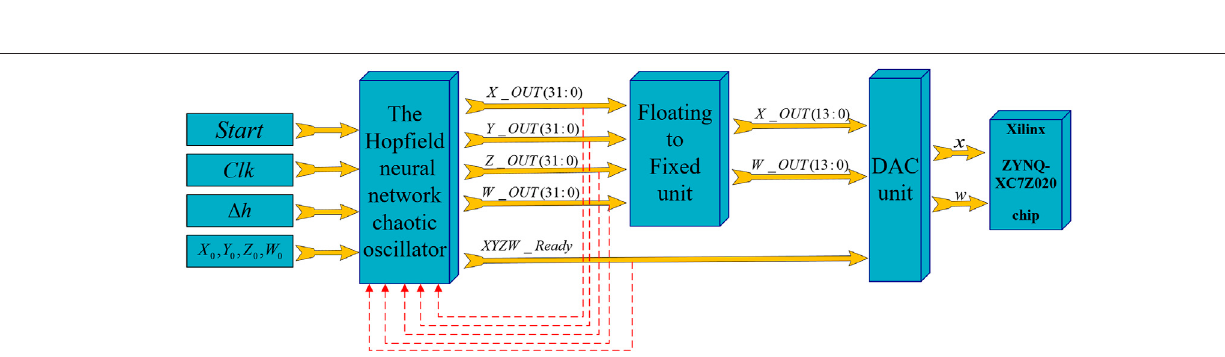
Therefore, in order to solve the chaotic degradation problem brought by FPGA implementation, the magnetic fl ux w of neuron x is used as ajudgment condition in the feedbackcontrollerto selectively interfere with neuron x . The speci fi c steps are as follows.